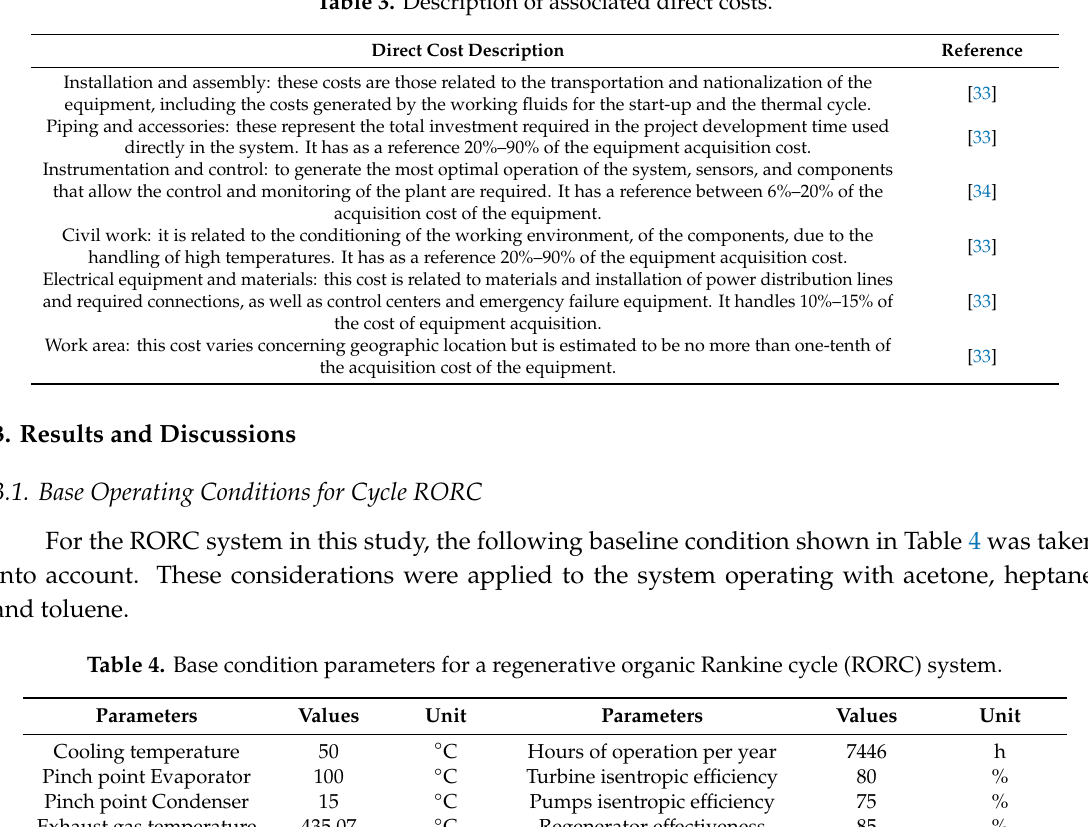
Table 3. Description of associated direct costs.